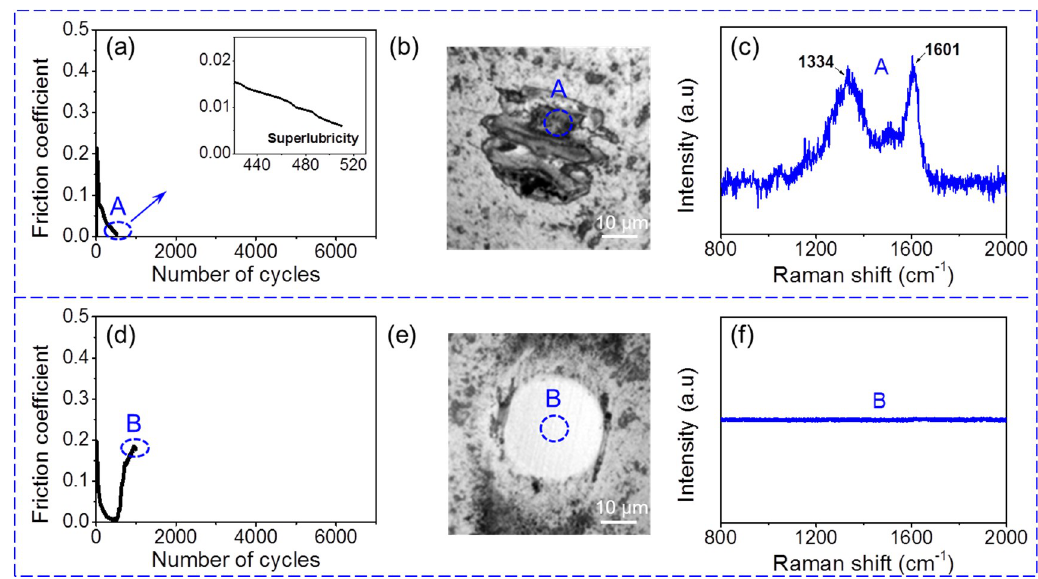
Figure 6. Characterizations of Al 2 O 3 ball surface after sliding ~510 cycles and ~1000 cycles at 5 N in vacuum. ( a ) Friction coefficient decreases to superlubricity state at ~510 sliding cycles. ( b , c ) respectively show topography of used Al 2 O 3 ball and Raman spectrum measured in contact region during superlubricity stage. ( d ) Friction coefficient increases with superlubricity failure. ( e , f ) show topography and Raman spectrum of Al 2 O 3 ball surface in this stage.